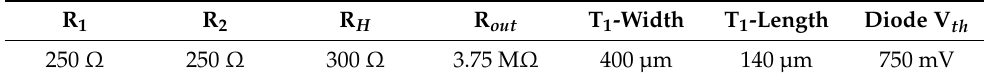
Figure 6. Hardware prototype of fully printed two-input neuron: ( a ) Circuit schematic; ( b ) annotated optical micrograph of the printed two-input neuron on flexible polyimide film. The image was digitally postprocessed and stitched together from multiple microscopy photos. Table 2. Design parameters of the printed neuron hardware